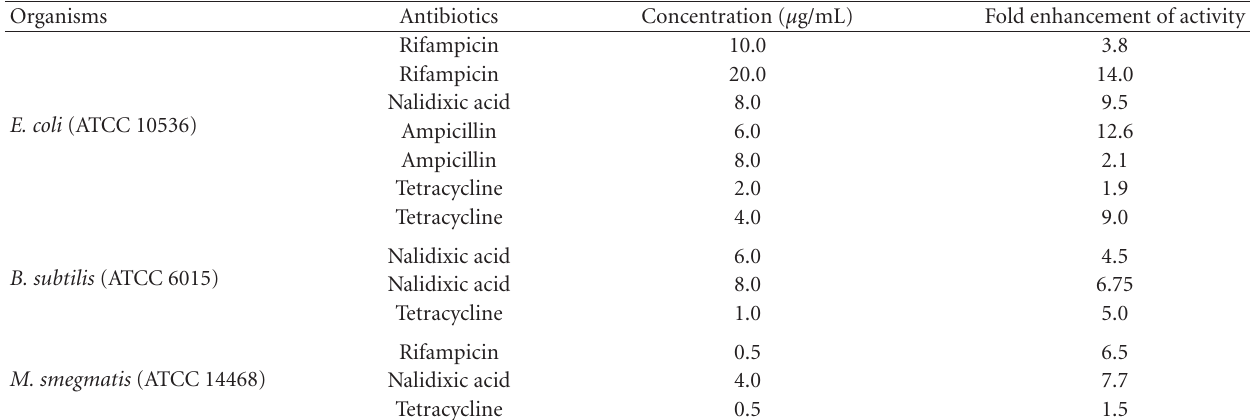
Table 22: Enhancement of antibiotic activity by glycyrrhizin (1 μ g/mL) in combination with antibiotics against di ff erent organisms [154, 155].